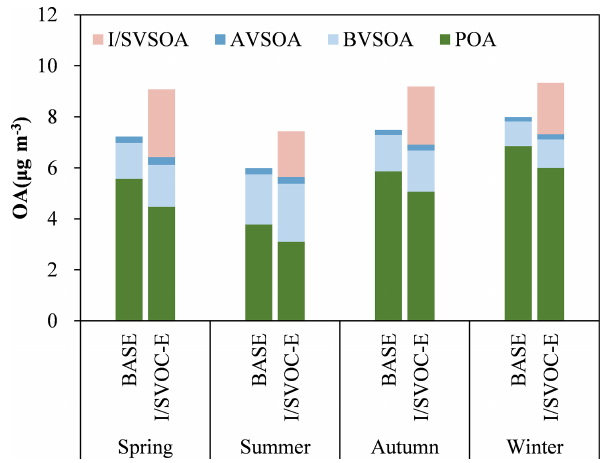
Figure 5. Comparisons of the regional average concentrations of POA and SOA formed from AVOCs, BVOCs, and I/SVOCs in dif- ferent seasons from the BASE and I/SVOC-E